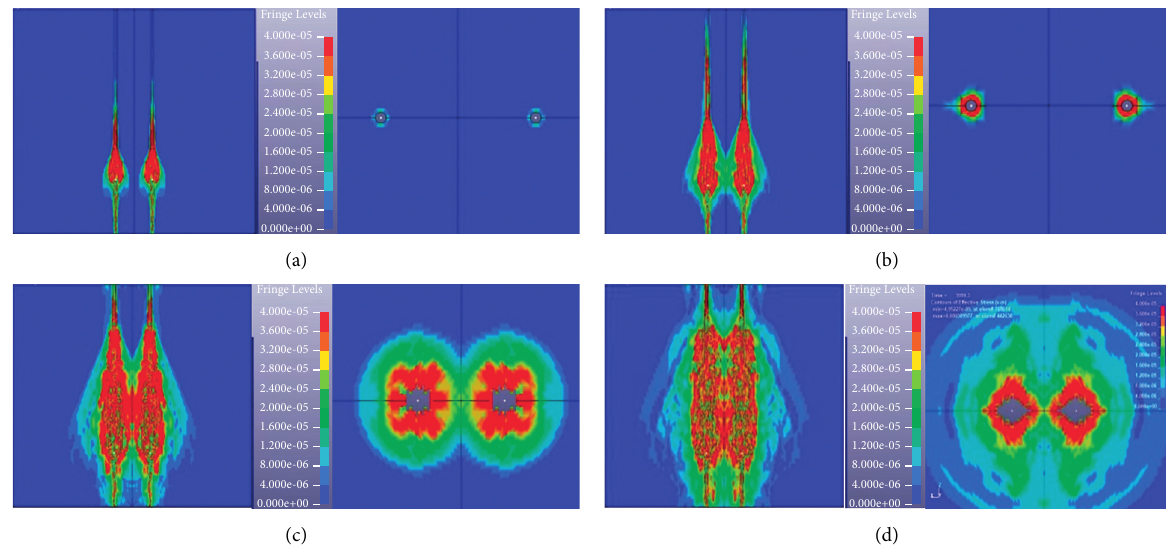
Figure 12: Stress nephograms of prone section and side section of concentrated hydraulic smooth blasting (unit: 10 5 MPa). (a) T � 1.00ms. (b) T � 2.00ms. (c) T � 4.00ms. (d) T � 6.00ms.